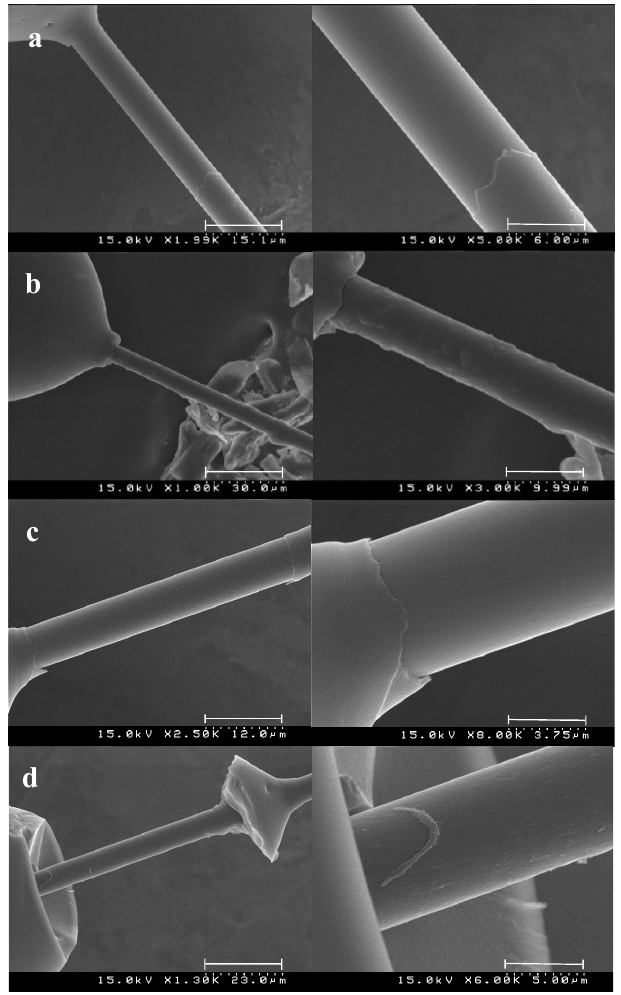
Figure 8. Fracture surfaces recorded after microdroplet test. ( a ) Epoxy matrix with unfunctionalized fiber, ( b ) epoxy matrix with lignin coated fiber, ( c ) cellulose propionate matrix with unfunctionalized fiber, and ( d ) cellulose propionate with lignin functionalized fiber.